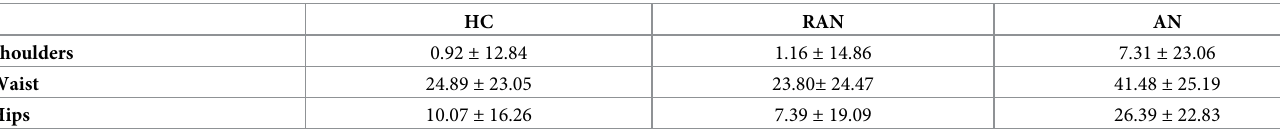
Table 6. Percentage of misestimation of shoulder, waist, and hips of